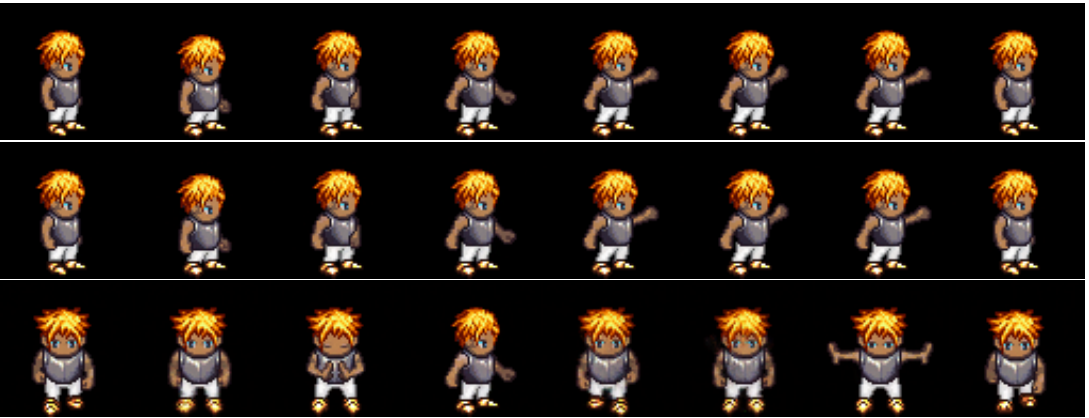
Figure 9. Example of randomly sampled generation on the Sprites dataset. We fixed the static variable and randomly sampled the dynamic variables. The top, middle, and bottom rows denote the input video and the results using DSVAE and the proposed method, respectively.